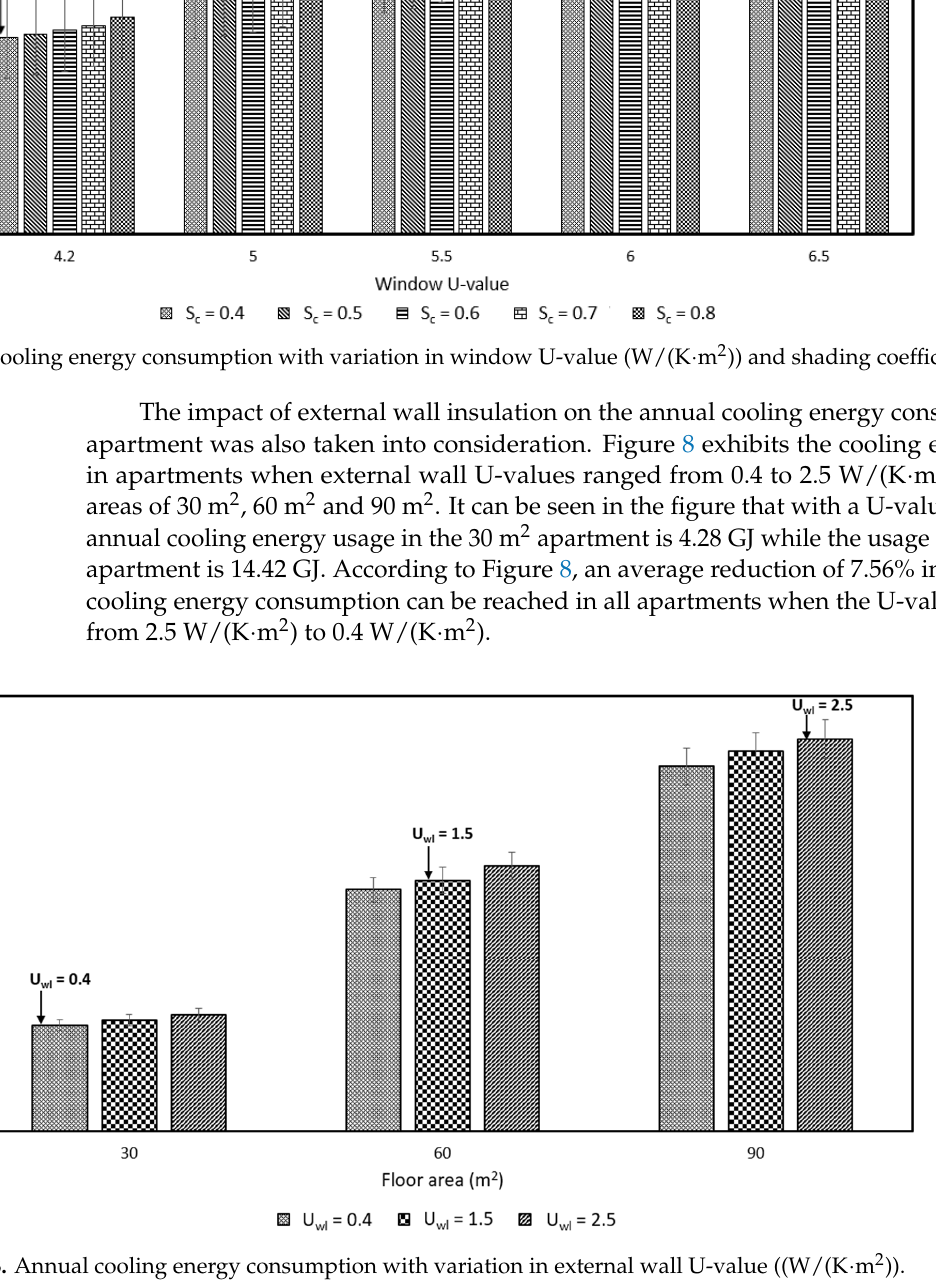
Figure 8. Annual cooling energy consumption with variation in external wall U-value ((W/(K·m 2 )).